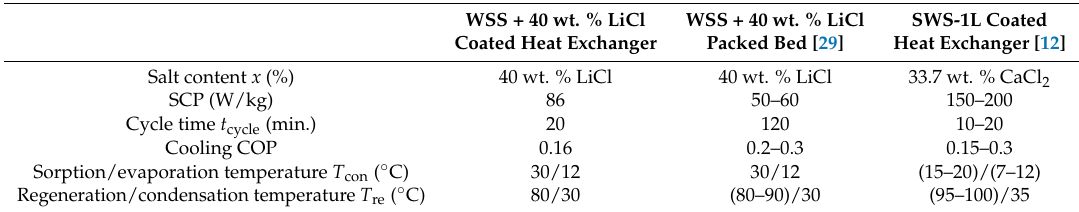
Table 4. Cooling performance comparison. SWS—selective water sorbents; SCP—specific cooling power; COP—coefficient of performance.